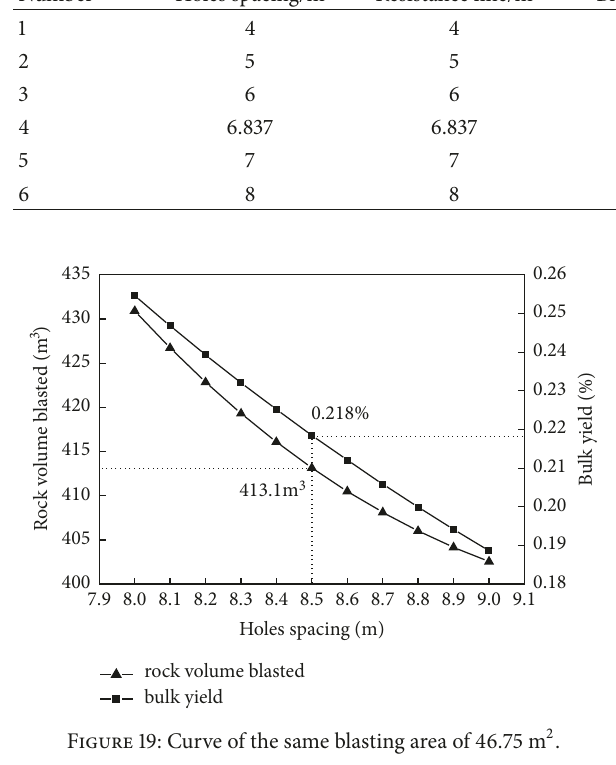
For the perfect square a × W =6.837 m × 6.837 m (area of 46.75 m 2 ), the blasting rock volume is 510.3 m 3 , but the bulk rate reaches 0.373%, which is 71.1% higher than 0.218% of a × W =8.5 m × 5.5 m, which corresponds to a worse blasting